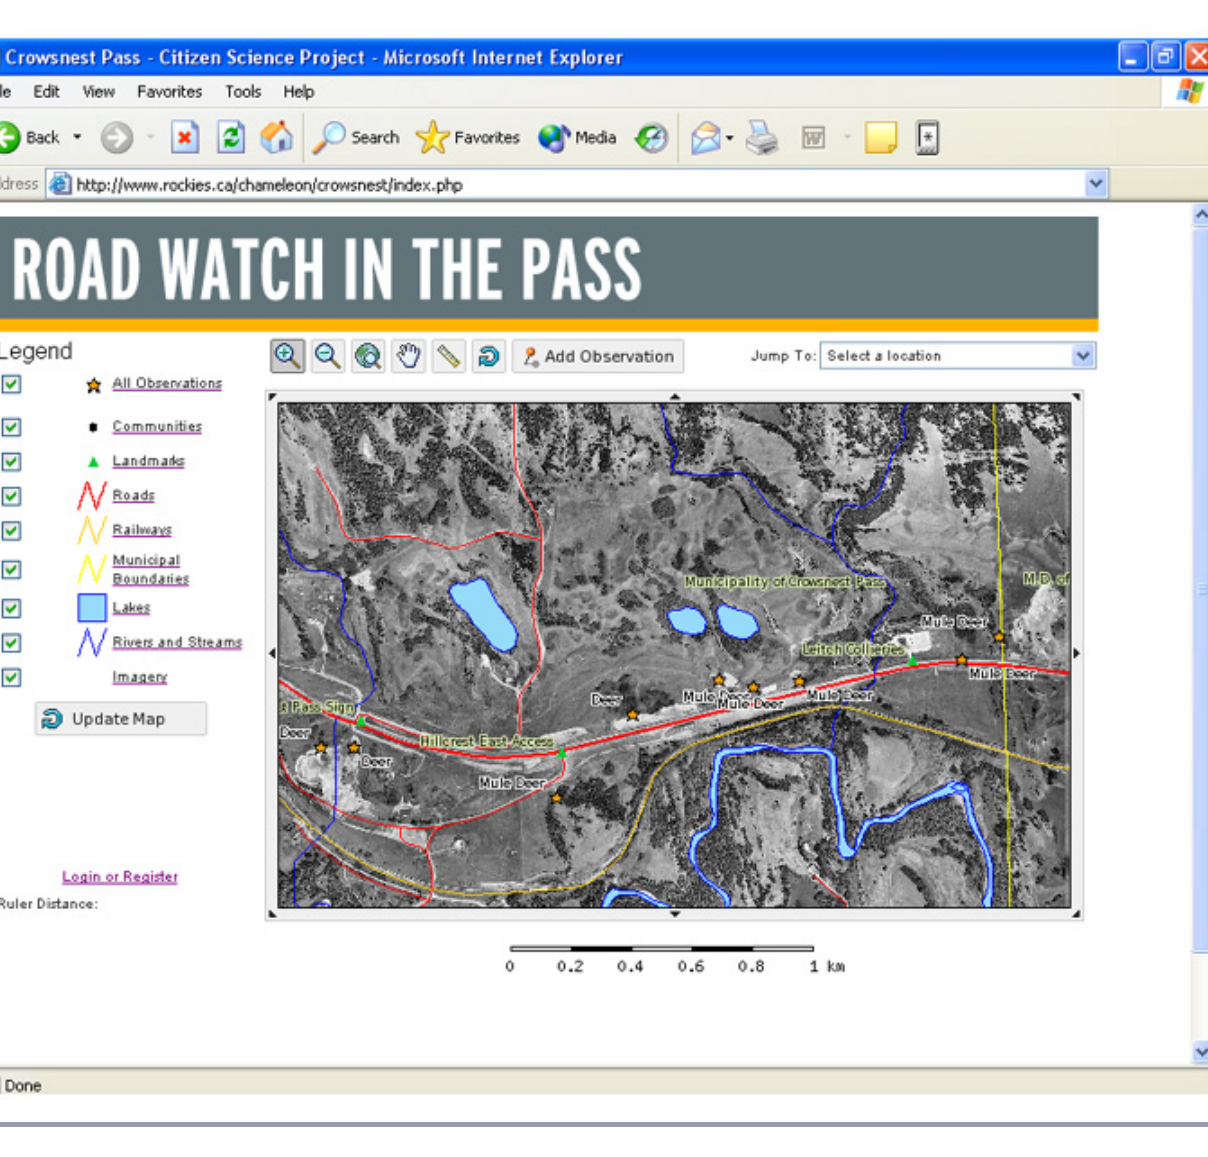
Fig. 4. Road Watch data displayed on the mapping